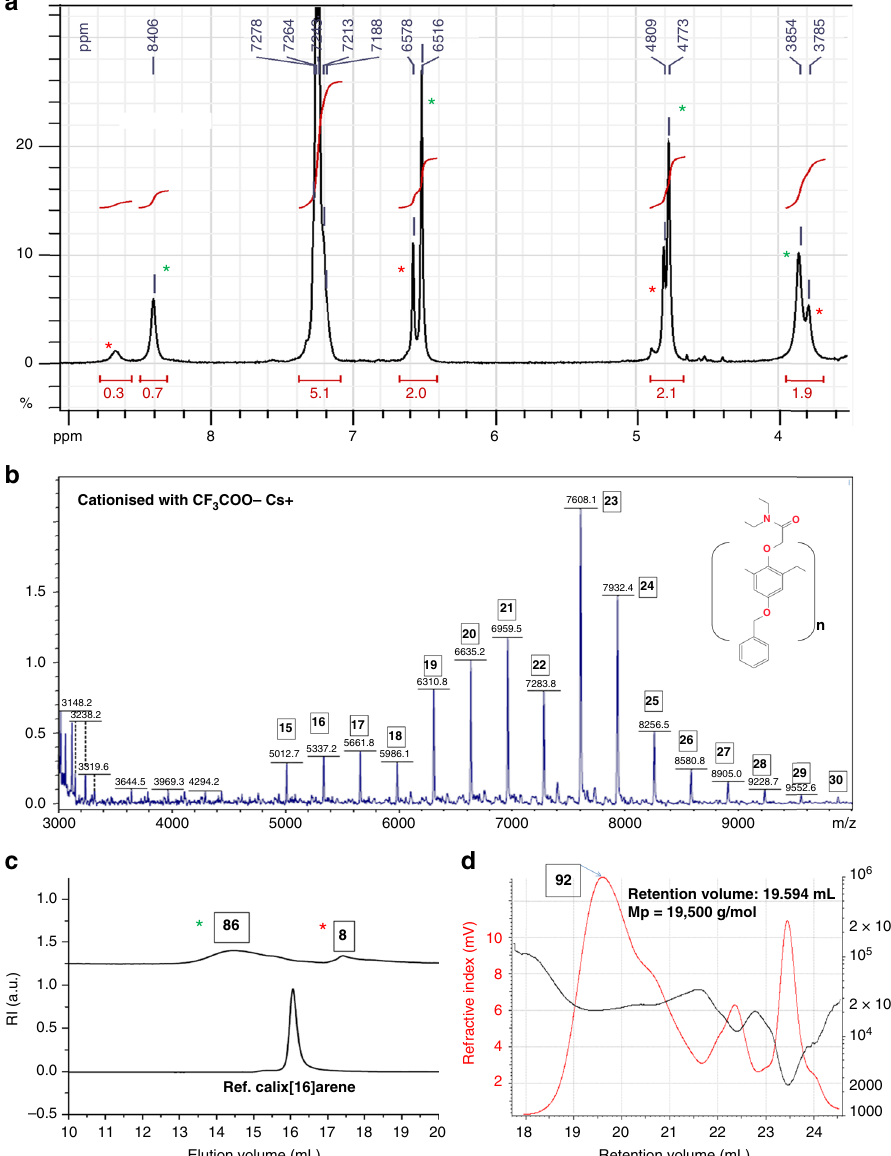
Fig. 7 Analysis of a sample with a size range centered around 90 PRUs as the main specie. a 1 H NMR (DMSO-d6); b linear mode MALDI-TOF MS (Cs + cationized); c SEC; and d SEC-MALS analyses of the largest calixarenes isolated (two-step process, 0.8 equivalent of RbOH vs phenol). PRU numbers are shown in boxes. The red and green asterisks are referring to calix[8]arene and giant calixarenes,